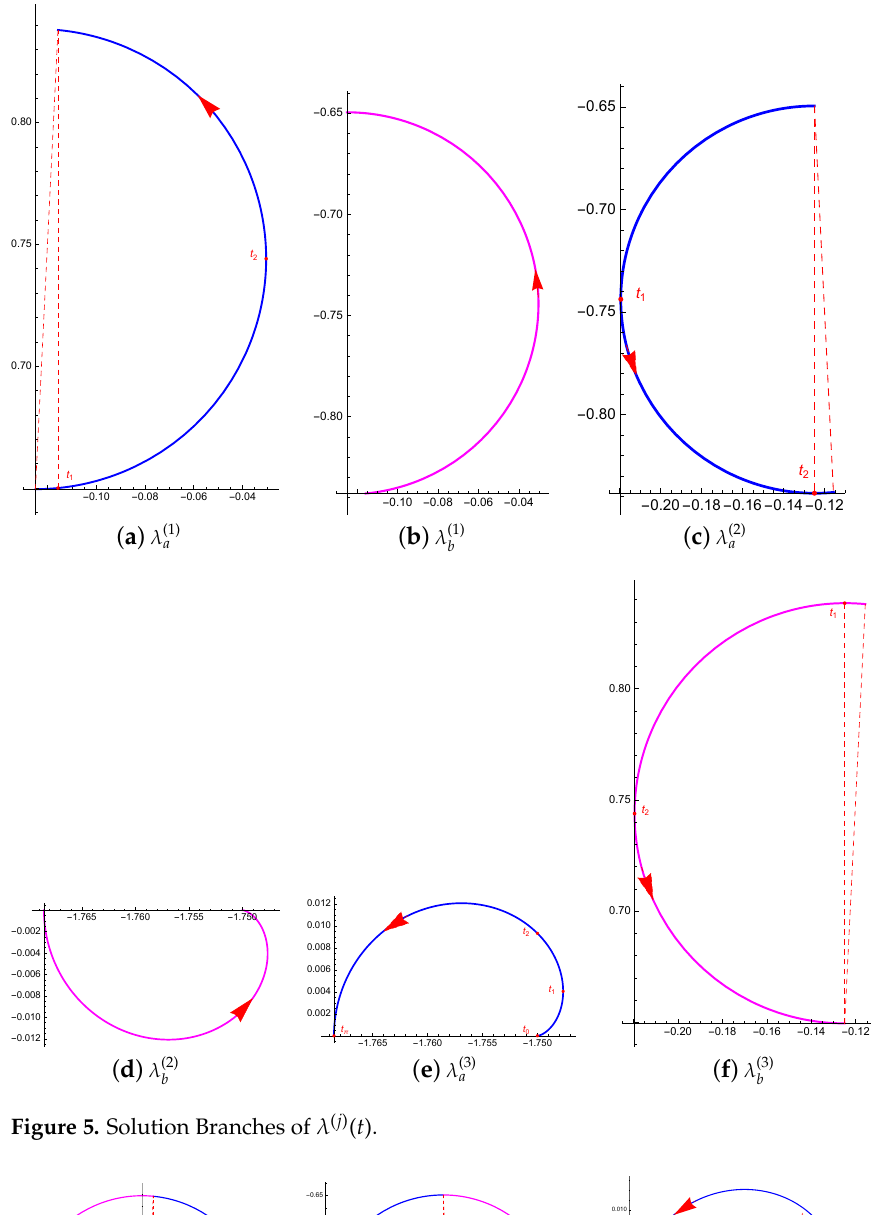
Figure 5. Solution Branches of λ ( j ) ( t ).